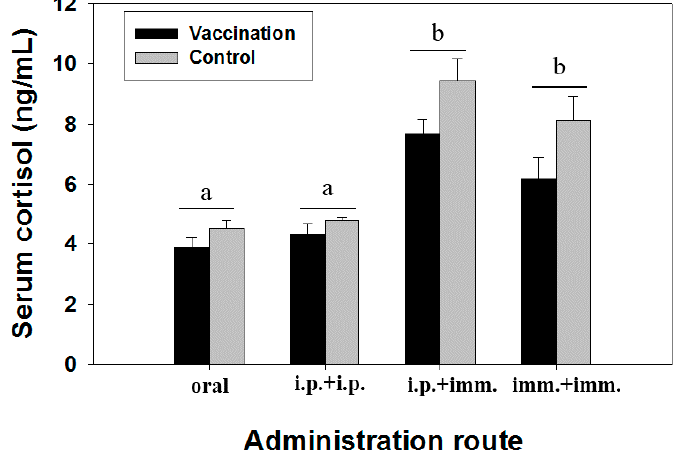
Figure 7. Serum cortisol of silver sea bream ( N = 7) immunized with formalin-killed bacterins through different administration routes. Significant difference among groups of vaccinated fish or unvaccinated fish was shown as a & b (b > a).